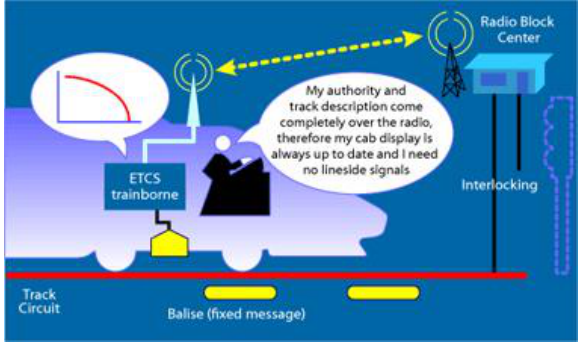
Figure 2. ETCS L2 [1]